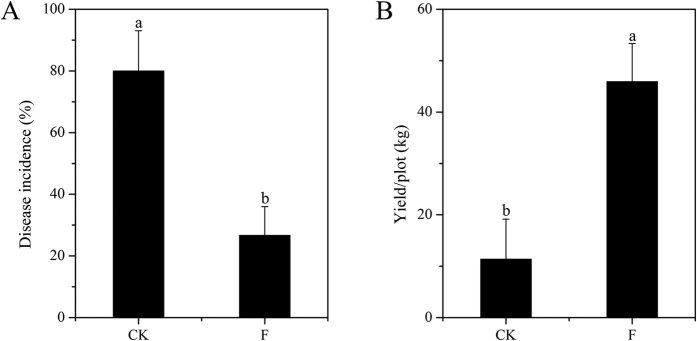
Disease incidence (A) and cucumber yield (B) of the control (CK) and fumigation (F) treatments. The significance of the difference was determined by two-tailed unpaired t-tests. Bars with different letters represent significant difference at p < 0.05.